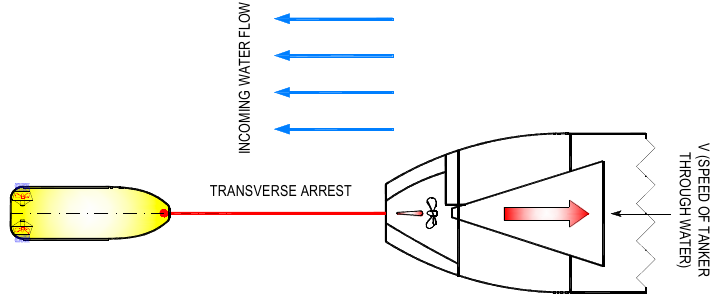
Figure 5. Transverse arrest mode by an ASD escort tug (6–8 knots). A transitional mode between direct and indirect methods. Drawing: Authors.